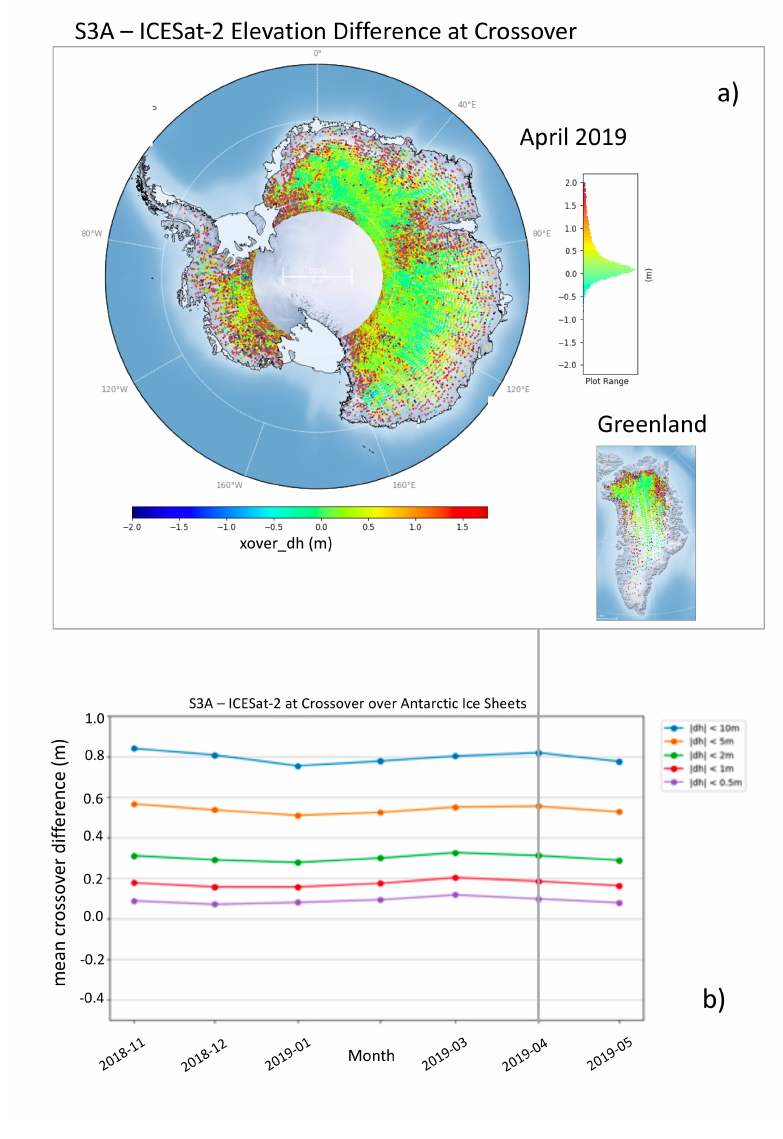
Figure 37. Comparison of S3B with ICESat-2 over Antarctica and Greenland.( a ) Map of crossover differences for April 2019. ( b ) Mean monthly difference between November 2018 and May 2019, with coloured lines representing different editing